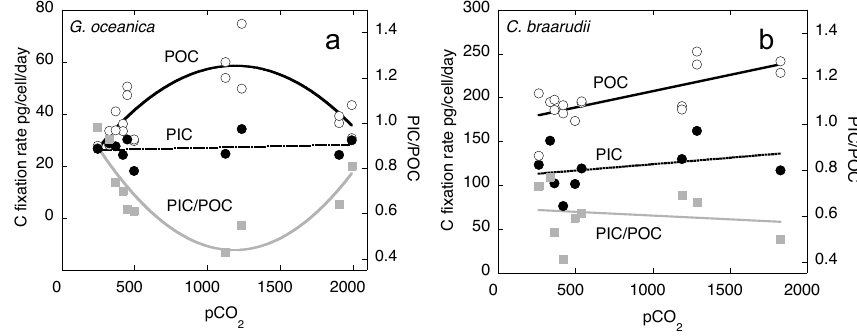
Fig. 3. POC (open circles), PIC (black circles) C fixation rates in pg/cell/day and PIC/POC ratio (grey squares) for G. oceanica with increasing p CO 2 . Like the earlier experiments of changing pH by Riebesell et al. (2000), there is a decrease in PIC/POC for G. oceanica with increasing p CO 2 but this is driven by the greater increase in POC relative to the nominal change in calcite production rates. We have plotted a 2nd order polynomial curve through the data where appropriate to highlight the trends.